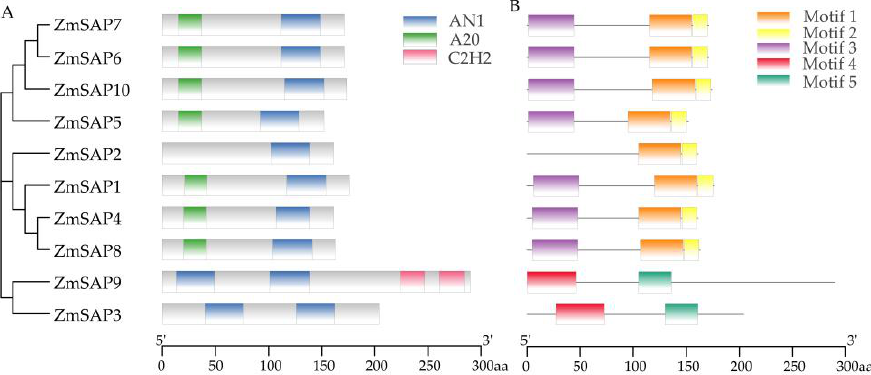
Figure 1. The schematic diagram of the conserved domain and motif composition of ZmSAP mem- bers. ( A ) The domain composition. ( B ) The motif composition. ( A ) The domain composition. ( B ) The motif